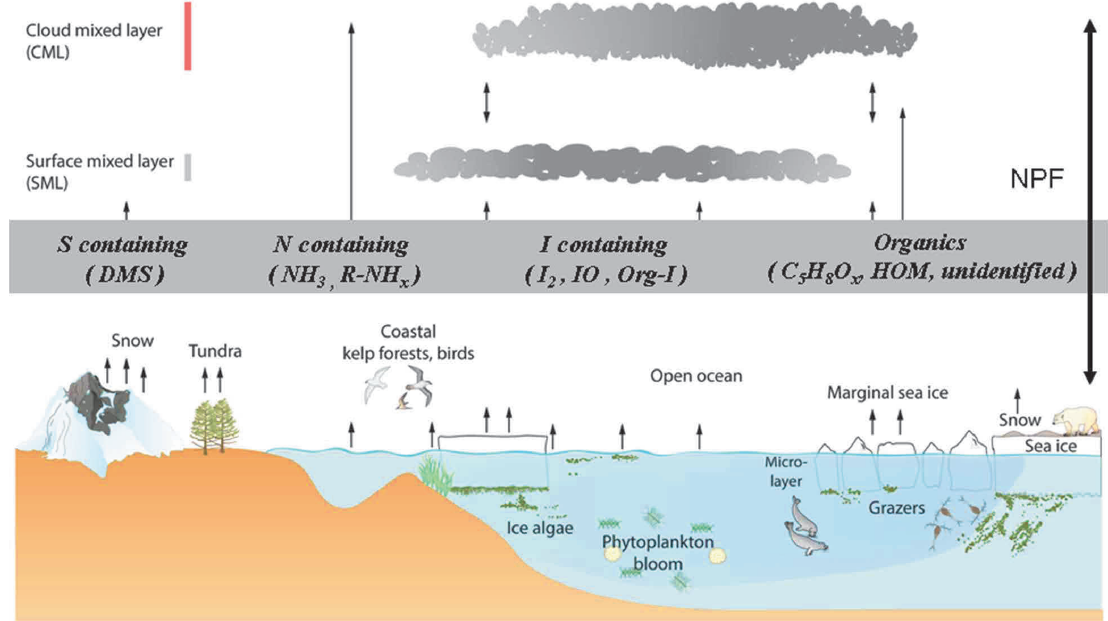
Figure 6. Schematic illustrations of the sea ice, microbiota, sea-to-air emissions, and new particle formation (NPF) occurring in the typical summertime stratus-topped Arctic boundary layer. Vertical red and grey bars broadly indicate the cloud mixed layer (CML) and surface mixed layer (SML), as inspired by Brooks et al. (2017). The grey box indicates known possible gas-phase NPF precursors from the potential Arctic natural terrestrial and marine sources drawn